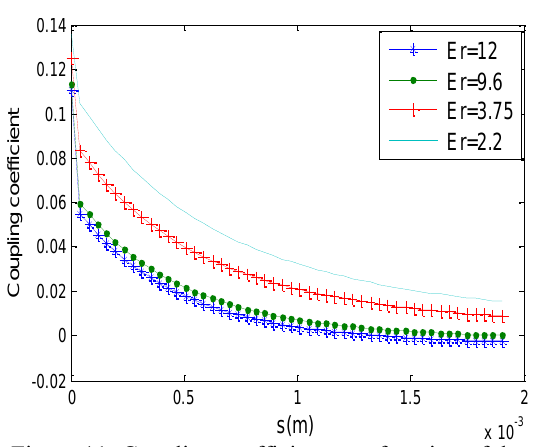
Figure 11: Coupling coefficient as a function of the gap s. We observe also the electric coupling k a depend of dielectric constant. The lower the dielectric constant, the stronger is the electric coupling. The numerical results also indicate that for low values of dielectric constant the variation of electric coupling with εr, is rapid while it is rather slow for high values of εr. These results agree well with the previous work published in